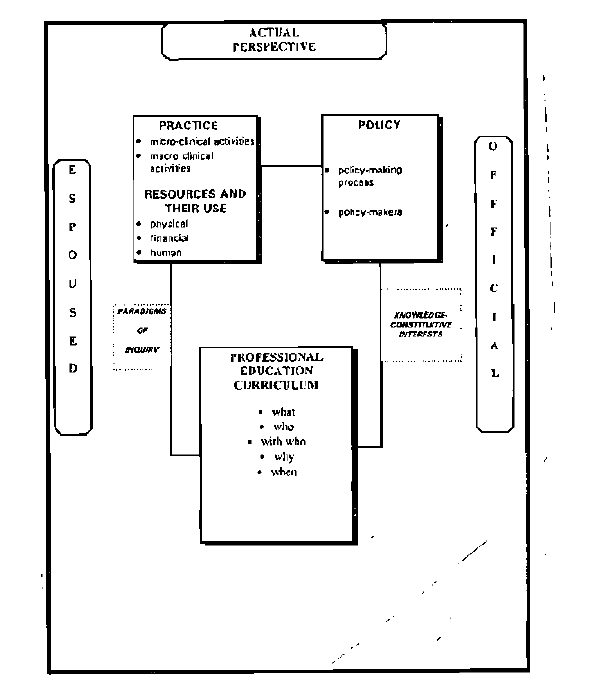
Figure 1: The curriculum of practice: A schematic diagram of the conceptual